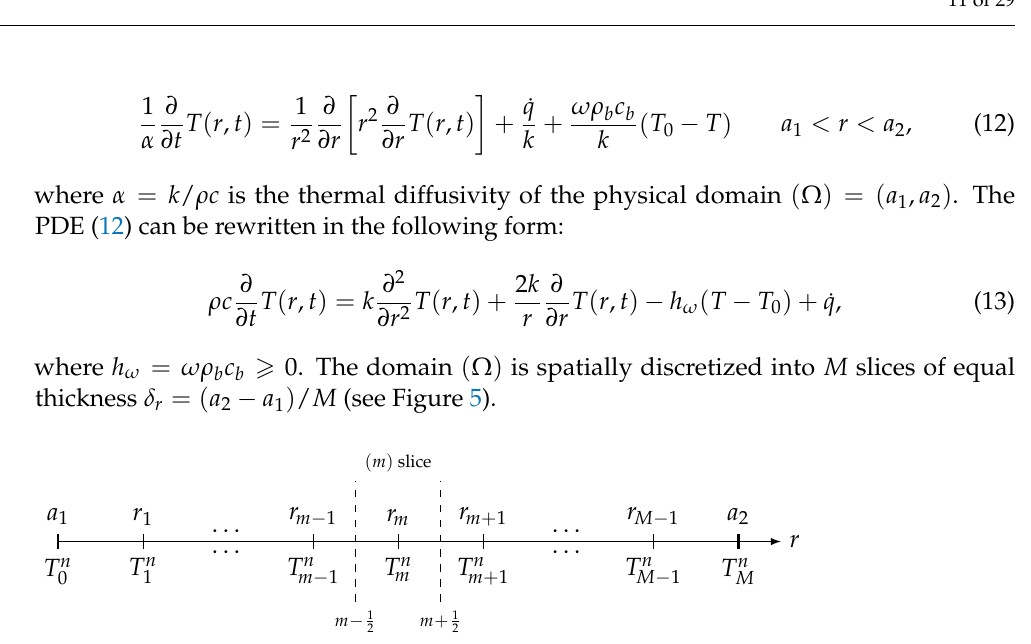
Figure 5. Spatial discretization of the spherical shell ( Ω ) = ( a 1 , a 2 ) into M slices of equal thickness δ r = ( a 2 − a 1 ) / M .